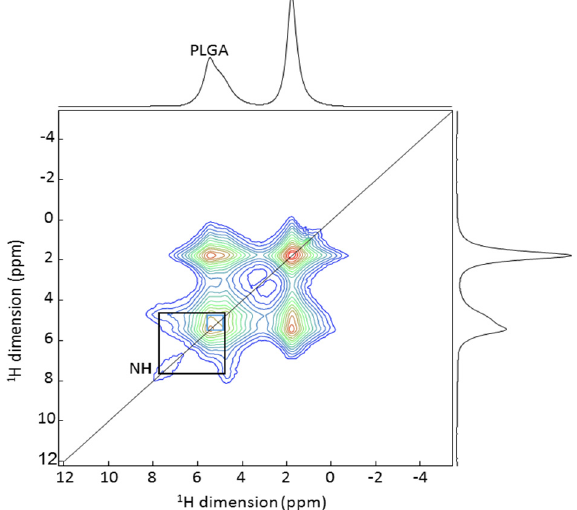
Figure 4. 2D 1 H- 1 H MAS NMR spectrum of PLGA 15 C NPs loaded with VCM. The black rectangle highlights the cross-correlation peaks between the NH of the VCM and the protons of the PLGA.